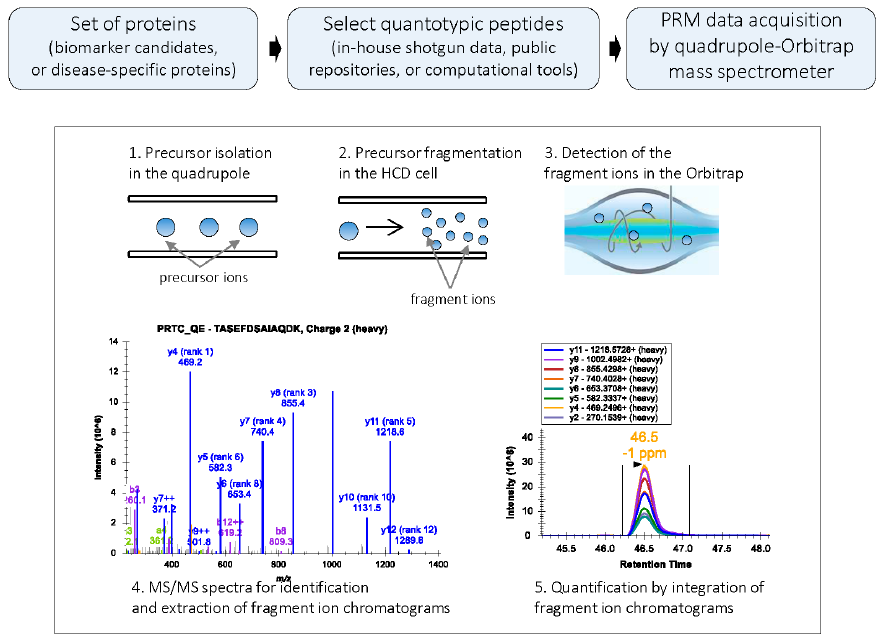
Figure 1. PRM workflow: In PRM, a target precursor ion is isolated in the quadrupole analyzer and fragmented in the HCD cell; the fragment ions are then detected in the Orbitrap mass analyzer. PRM generates high resolution, full MS/MS data. During data processing, the MS/MS spectrum is used for the confident identification of the peptide; subsets of fragment ions with highest intensities in the MS/MS spectrum are used for quantification. Peak areas of fragment ions are extracted using <10 ppm mass window and integrated across the elution profile. The Skyline platform supports PRM-based targeted MS quantification [20].